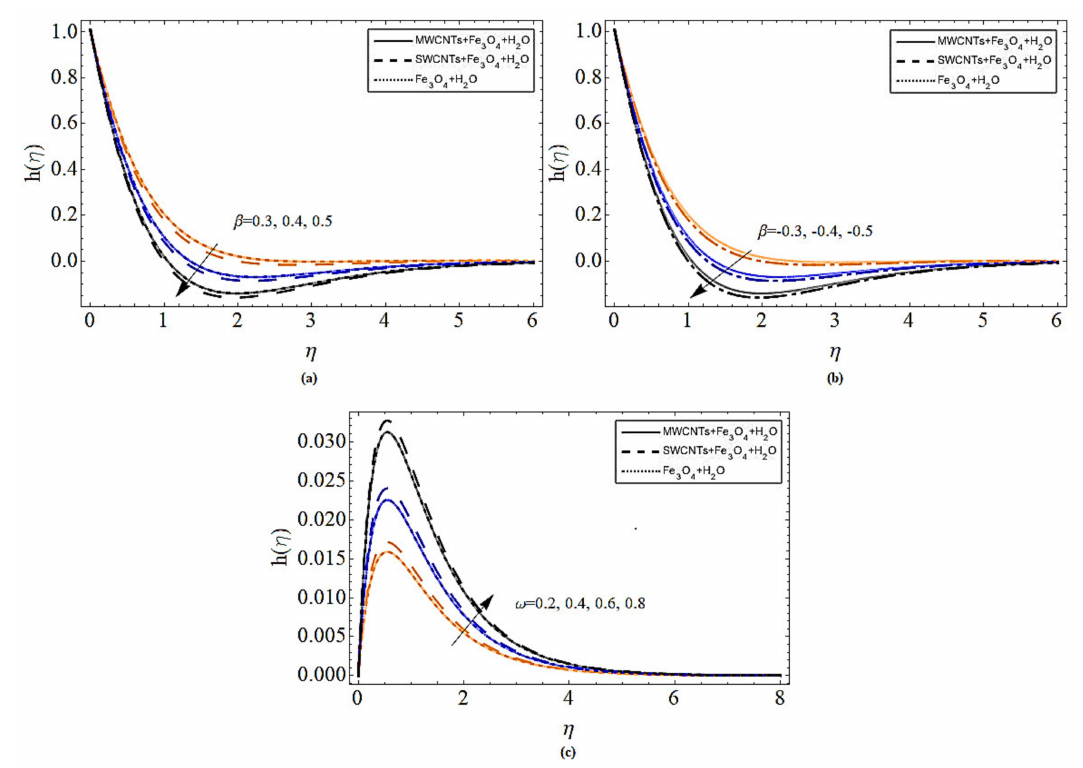
Figure 3. The behavior of radial velocity h ( η ) versus ( a ) injection parameter + β ( b ) suction parameter − β ( c ) disk rotation parameter ω .